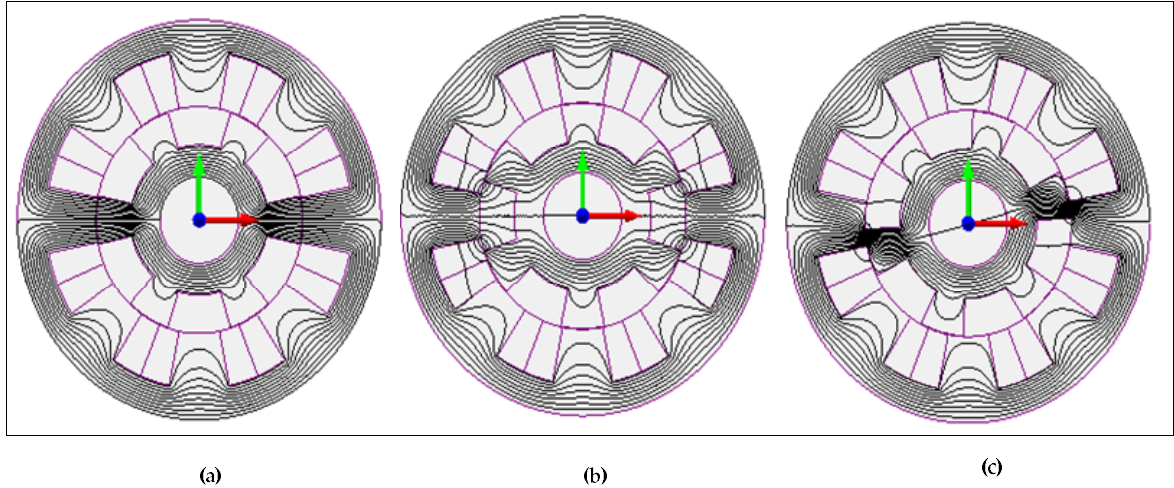
Figure 6. ( a ) Aligned position, ( b ) unaligned position and ( c ) midway position.